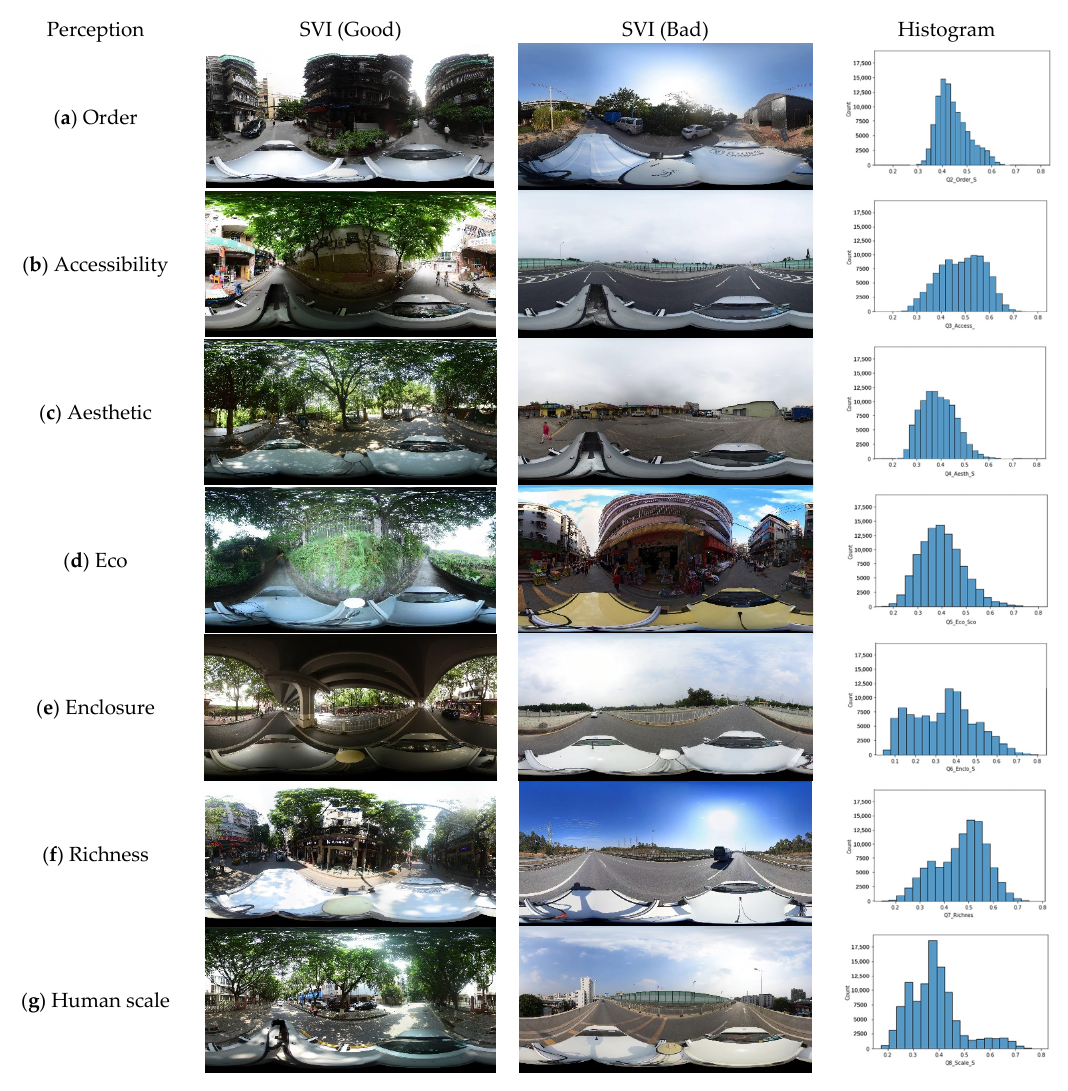
Figure 6. Data distribution of 7 types of Streetscape perception.